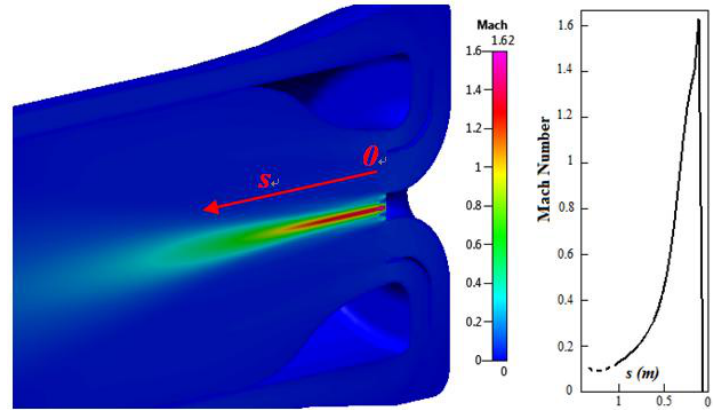
Figure 9. Fuel Mach number: contour plot and chart.